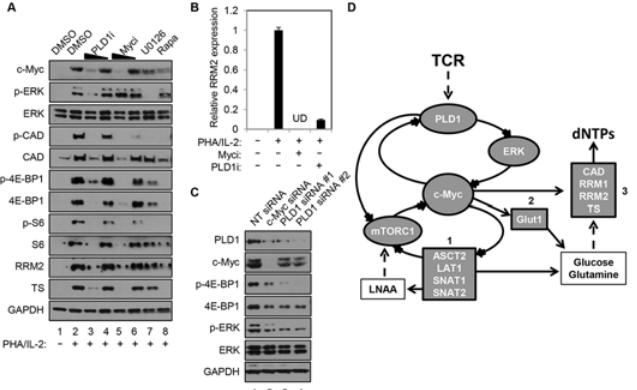
Fig 1. PLD1 inhibition decreases the c-Myc-dependent dNTP biosynthetic transcriptional program. (A) Western blot analysis of protein expression in whole cell lysates prepared from resting primary human CD4 + T cells that were pretreated for 24h with DMSO vehicle, 10 or 5 μ M of PLD1i, 50 or 25 μ M of c-Myci, 10 μ M U0126, or 100 nM of rapamycin. Cells were either left resting or stimulated with 5 μ g/ml PHA and 20 U/ml IL2 in the continued presence of DMSO or inhibitors for 48h before cell harvest. (B) RRM2 mRNA levels in resting primary CD4+ T cells pretreated for 24h with DMSO vehicle, 100 μ M c-Myci, or 10 μ M PLDi, then left resting or stimulated as in (A) as determined by quantitative real-time PCR. mRNA abundance in mock controls was set to1. Error bars represent standard error from the mean of triplicate samples. Data are representative of experiments from three independent donors. UD; undetectable levels of mRNA. (C) Resting primary human CD4+ T cells were transfected via nucleofection with siRNAs targeting PLD1 or c-Myc. Cells were allowed to recover for 24 h and then stimulated for 48 h with anti-CD3/anti-CD28 beads, harvested and western blot analysis performed as in (A). (D) In activated CD4+ T cells, PLD1 is shown to regulate c-Myc through ERK or mTOR-dependent mechanisms. This results in the increased expression of genes essential for uptake of amino acids (box 1), glucose (box 2), and synthesis of nucleotides (box